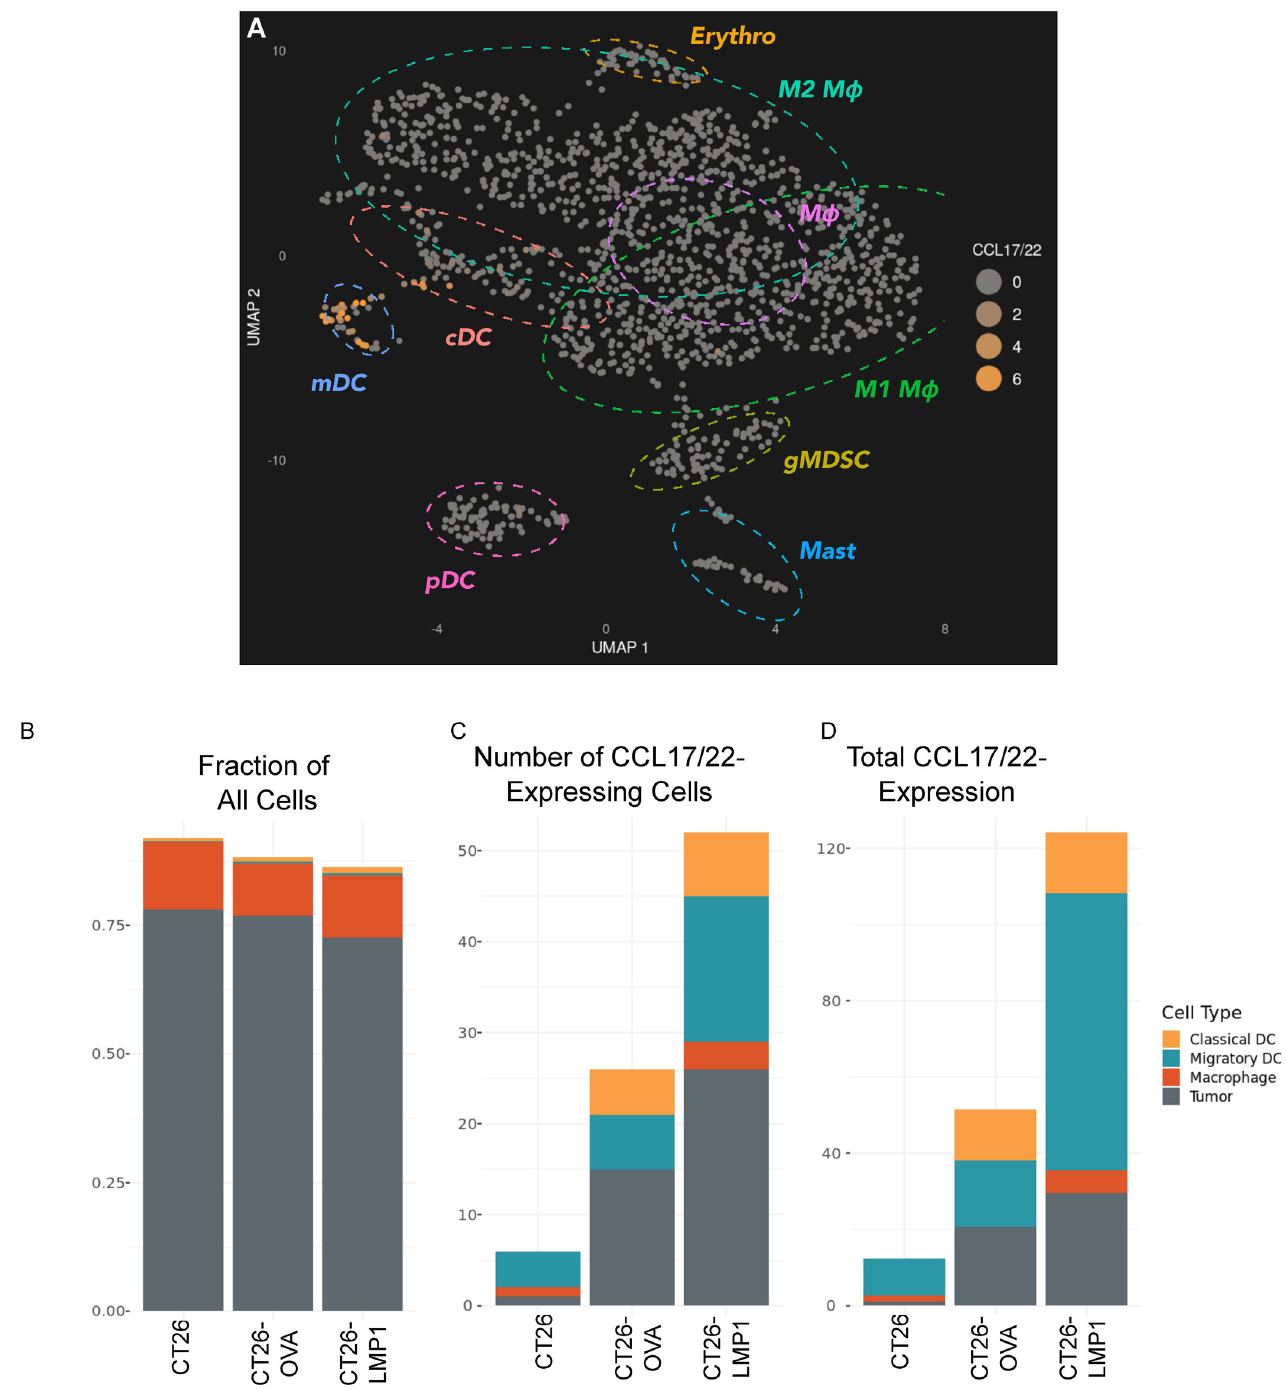
Fig 7. CCL17/22 expression is restricted to tumor and myeloid cells and increases with LMP1 expression. (A) Combined CCL17/22 expression is indicated on a 2D UMAP projection of all myeloid cells from CT26, CT26-OVA, and CT26-LMP1 tumors as identified by single-cell RNA Seq. CCL17/22 expression is in Transcripts per Million (TPM). Ellipses indicate cell types: Erythro = Erythrocyte; Mast = Mast Cell; gMDSC = granulocytic Myeloid-Derived Suppressor Cell; mDC = migratory Dendritic Cell; cDC = classical Dendritic Cell; pDC = plasmacytoid Dendritic Cell; M1 M f = M1 Macrophage; M2 M f = M2 Macrophage; M f = Macrophage, unknown subtype. Stacked barcharts show, for each tumor type: (B) the fractions of all cells from the five CCL17/ 22-expressing cell types; (C) the total number of cells from B with CCL17/22 TPM > 1.0; (D) the sum of CCL17/22 TPM from the cells in (C).